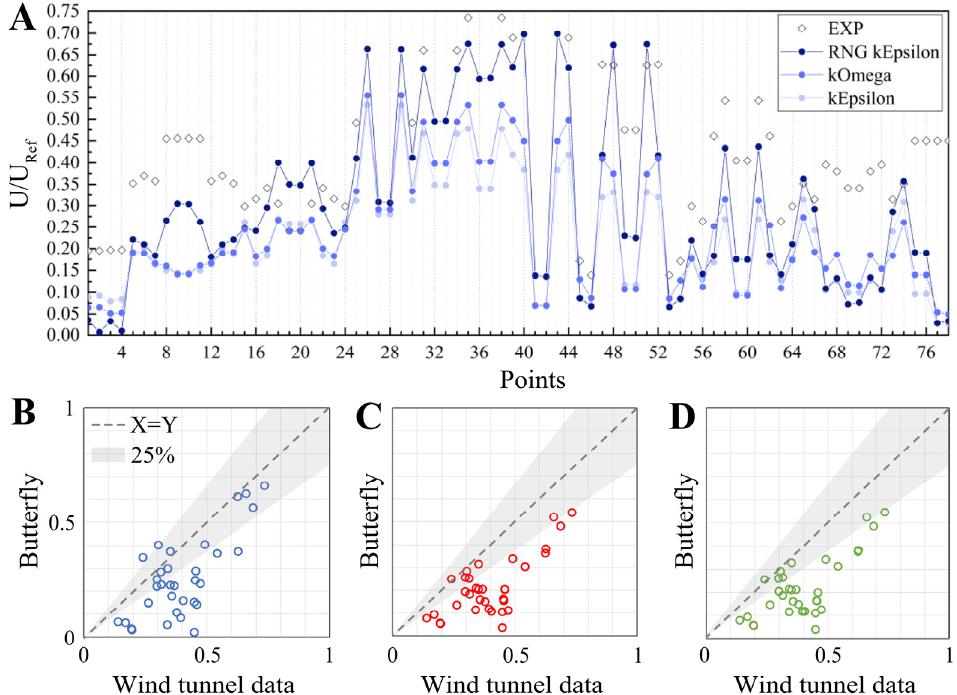
Figure 10. ( A ) Comparison of wind velocity ratio of measured points at pedestrian level obtained by Butterfly using different turbulence models; correlation analysis between ( B ) RNGKE, ( C ) SST k- ω (SSTKW), ( D ) standard k- ε (STKE) turbulence model results, and wind tunnel data, respectively. U / U ref is the ratio of simulated wind velocity U to reference velocity U ref (6.65 m/s). Shaded regions in ( B – D ) mark the prediction envelopes with allowable errors of less than 25%.